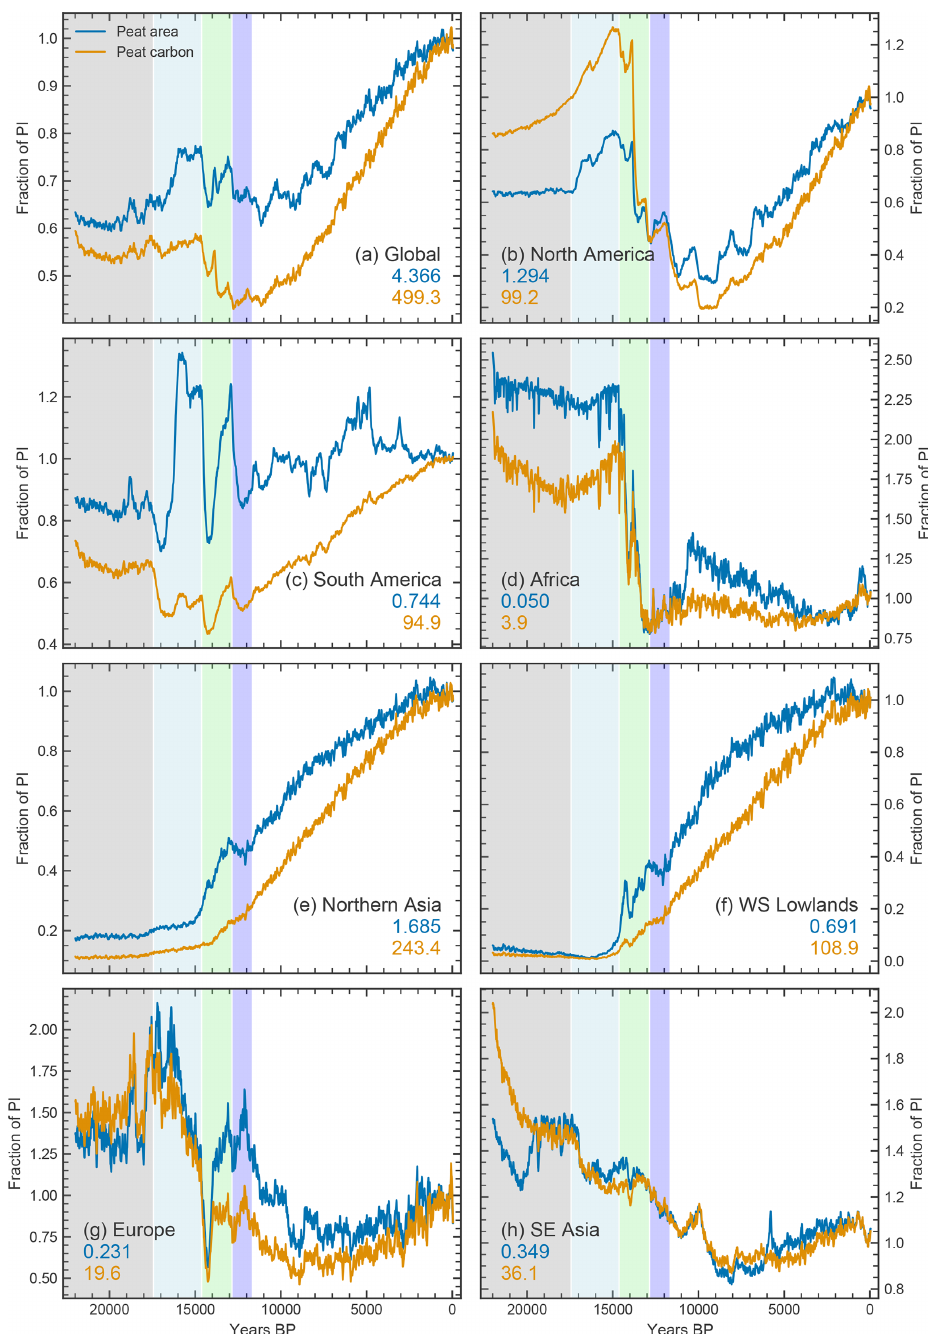
Figure A1. Simulated global and regional peatland area and carbon dynamics over time, relative to PI levels. PI levels are given in millions of square kilometers (Mkm 2 ) for peat area and in gigatons of carbon (GtC) for peat carbon. The extent of the northern Asia, western Siberian (WS) lowlands, and Southeast Asia regions are shown in Fig. 1. The background colors indicate different time periods, as in Fig.